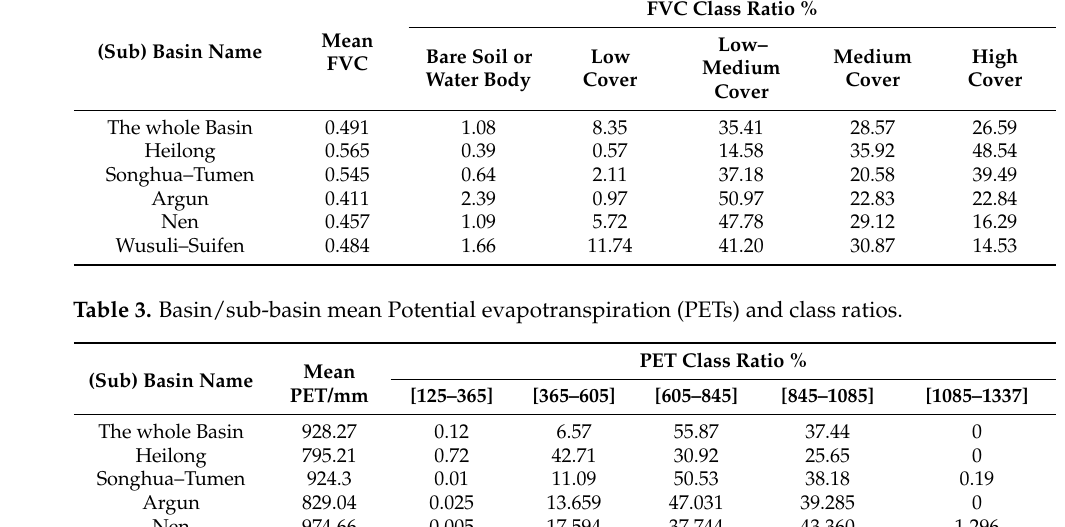
Figure 7. Time-series changes of fractional vegetation coverage in the basin. The annual average data were divided into five groups according to classification levels and equal intervals to analyze the impact of FVC changes on PET (Tables 2 and 3). Table 2. Basin/sub-basin mean fractional vegetation coverage (FVCs) and class ratios.